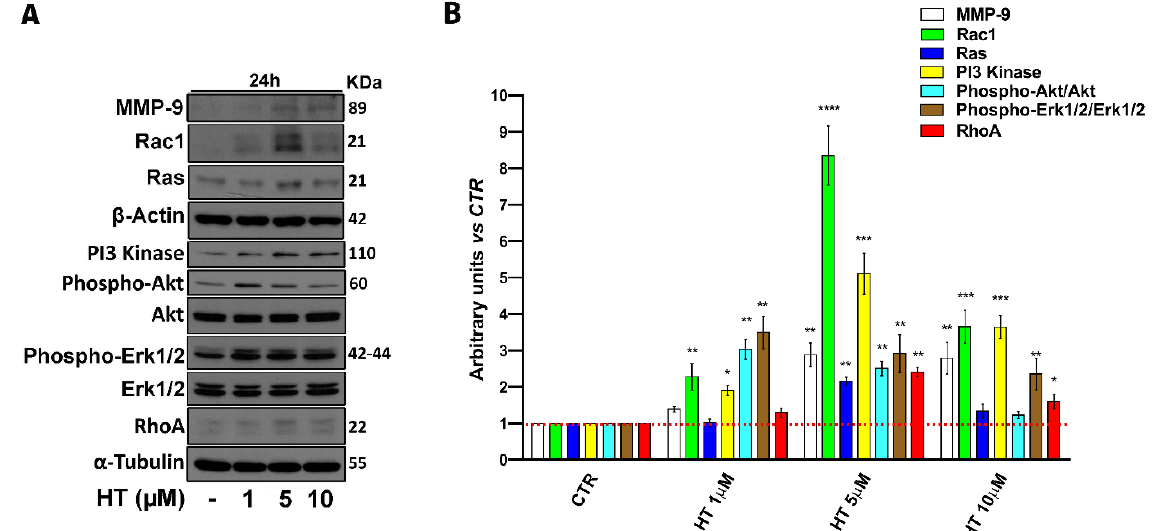
Figure 4. HT induces migration protein expression in HaCaT cells. ( A ) Western blot analysis of MMP-9, Phospho Erk1/2, Erk1/2, Phospho-Akt, Akt, PI3 Kinase, RhoA, Rac1, and Ras in whole cell extracts from HaCaT cells treated for 24 h with HT 1–10 µ M. β -Actin and α -Tubulin were used as the control of protein loading. The panel shows a representative western blot of four different experiments with similar results. ( B ) Histograms represent mean ( ± SD) in densitometry units of scanned immunoblots from four different experiments (2-way ANOVA, * p < 0.05, ** p < 0.01, *** p < 0.001, and **** p <